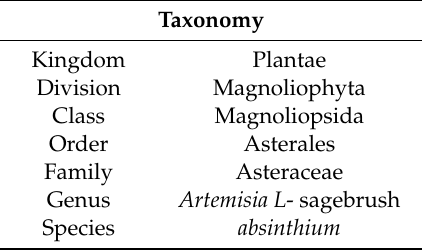
Table 1. Scientific classification of Artemisia absinthium .